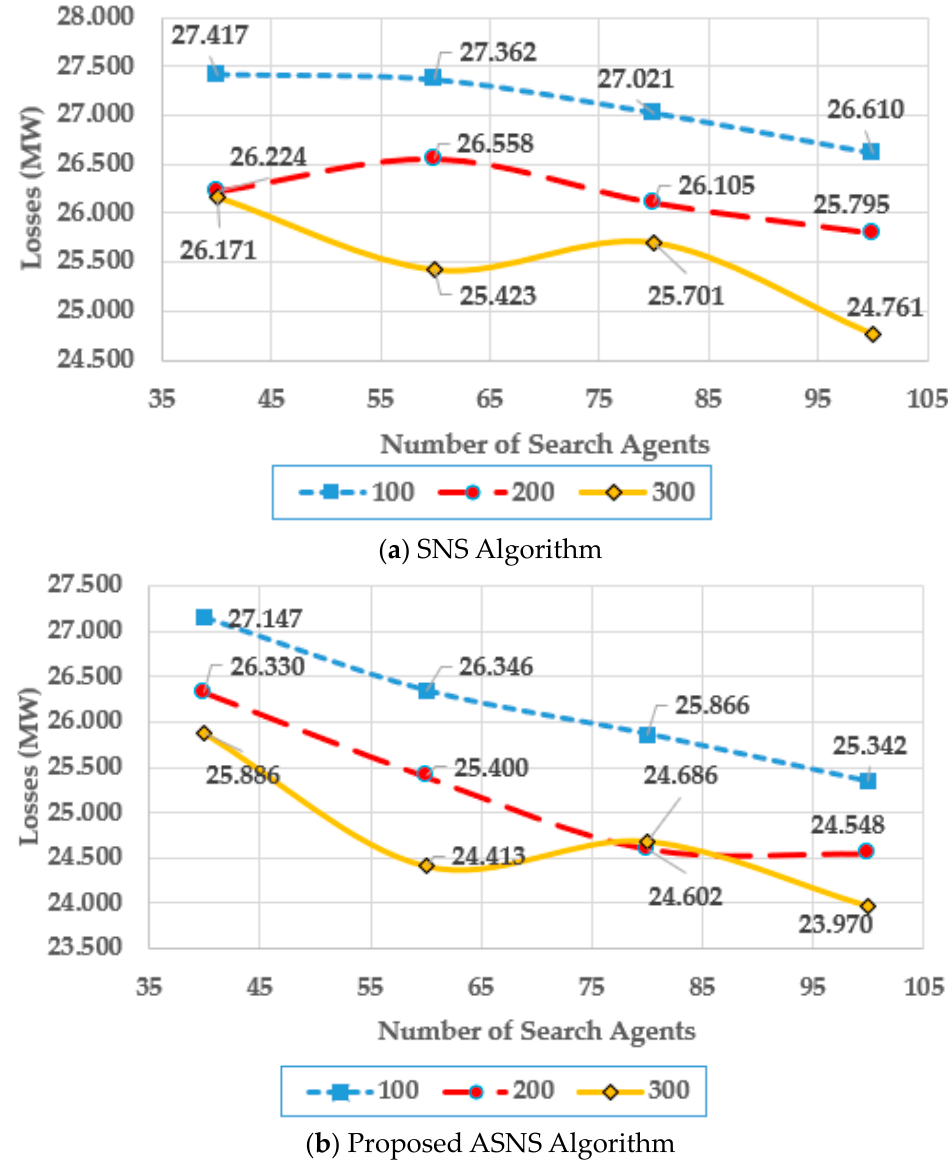
Figure 19. Parameter Tuning of SNS and ASNS Algorithms for Case 1 for IEEE 57-bus system.